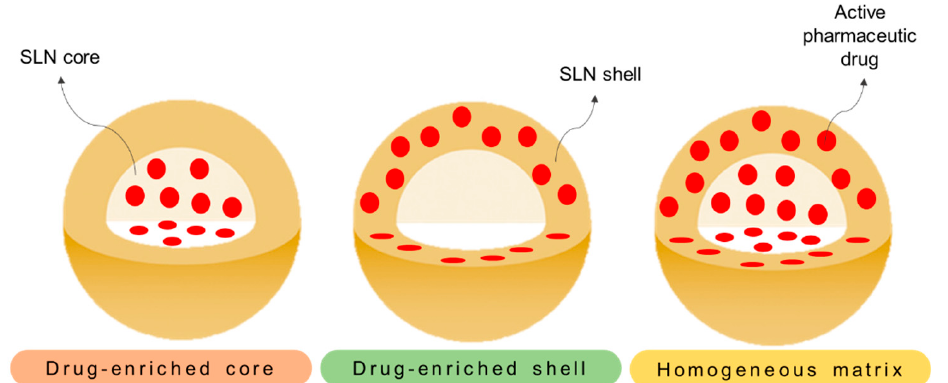
Figure 6. Different representative models of SLNs. On the different models, the drug distribution is represented across (i) the core (drug-enriched core), (ii) the surfactant shell (drug-enriched shell), and (iii) through the core and shell (homogeneous matrix).